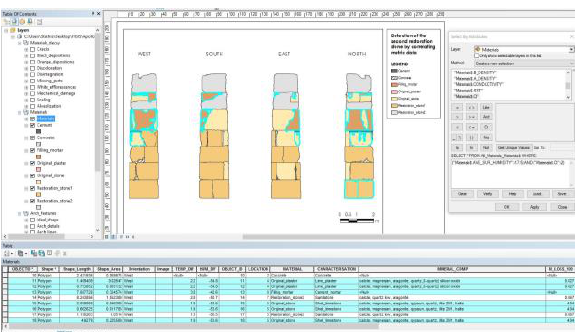
Figure 14: GIS analysis operations on the thematic map of building materials